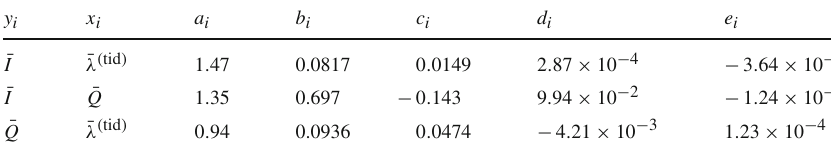
Table 3 Coefficients for the fitting formulae of the neutron star and quark star I -Love, I − Q and Love- Q